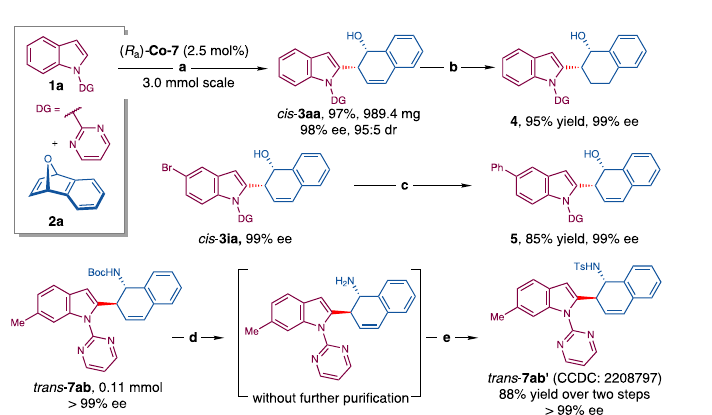
Fig.7|Gram-scalereactionandproducttransformations. Reactionconditions: (a) 1a (3.0mmol), 2a (4.5mmol), NaOPiv·H 2 O (0.9mmol), ( R a )- Co-7 (0.075mmol), TFE/HFIP (12.0mL, v/v=3:1), 50°C, 48h. (b) Pd/C (0.1 equiv), H 2 (1atm), EtOAc (0.1M), rt., 24h. (c) PhB(OH) 2 (2.0 equiv), Pd 2 dba 3 (2.5mol%),